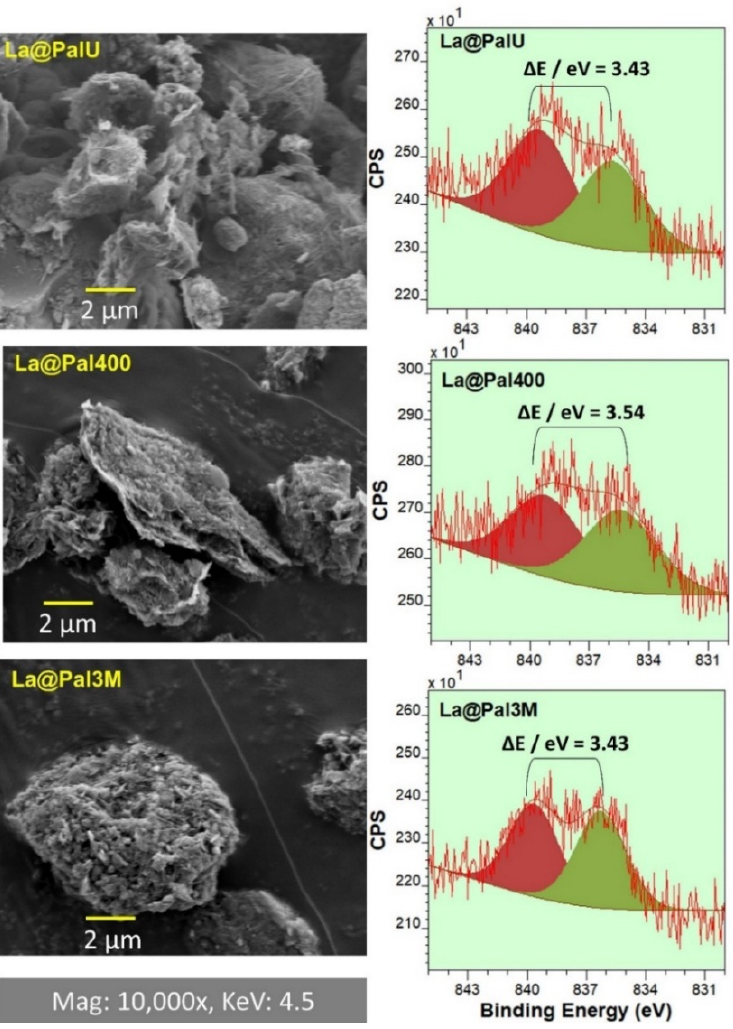
Figure 3. SEM images of La-functionalised palygorskite materials. Microscopic images (SEM and TEM) of the raw palygorskite are provided as the Supplementary Information SI Figure S4. High- resolution XPS and model fitting of La signature spectra are in the right column of the figure.